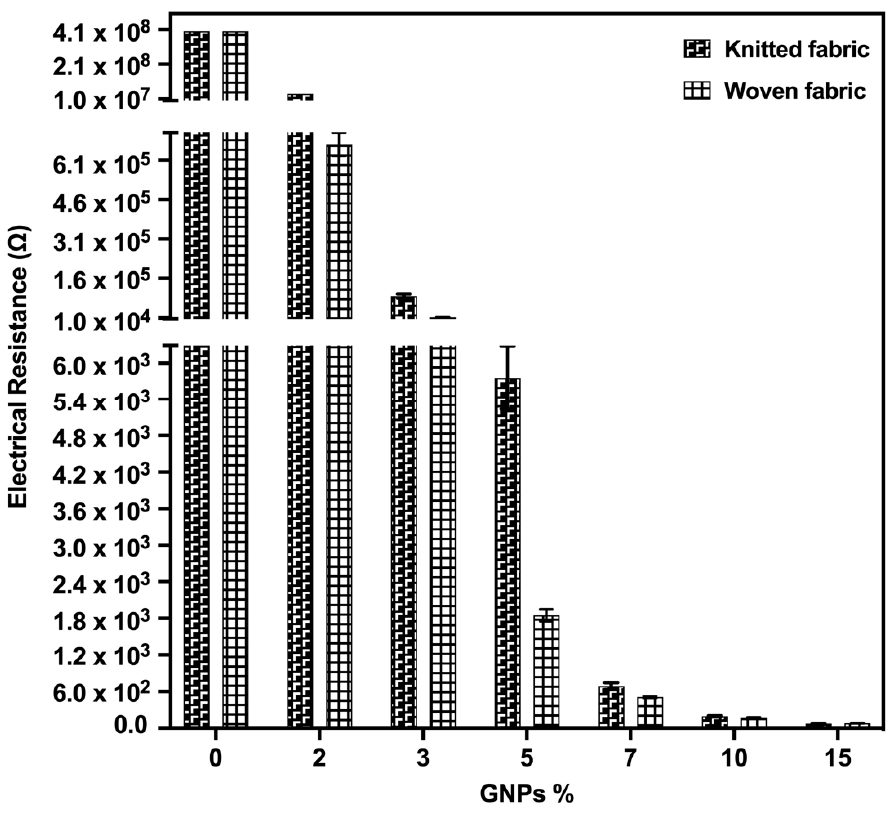
Figure 10. Electrical resistance values for samples functionalised with different GNPs%, in knitted and woven fabrics. The sample with 0% GNPs refers to the control sample, doped with the polymeric matrix only.